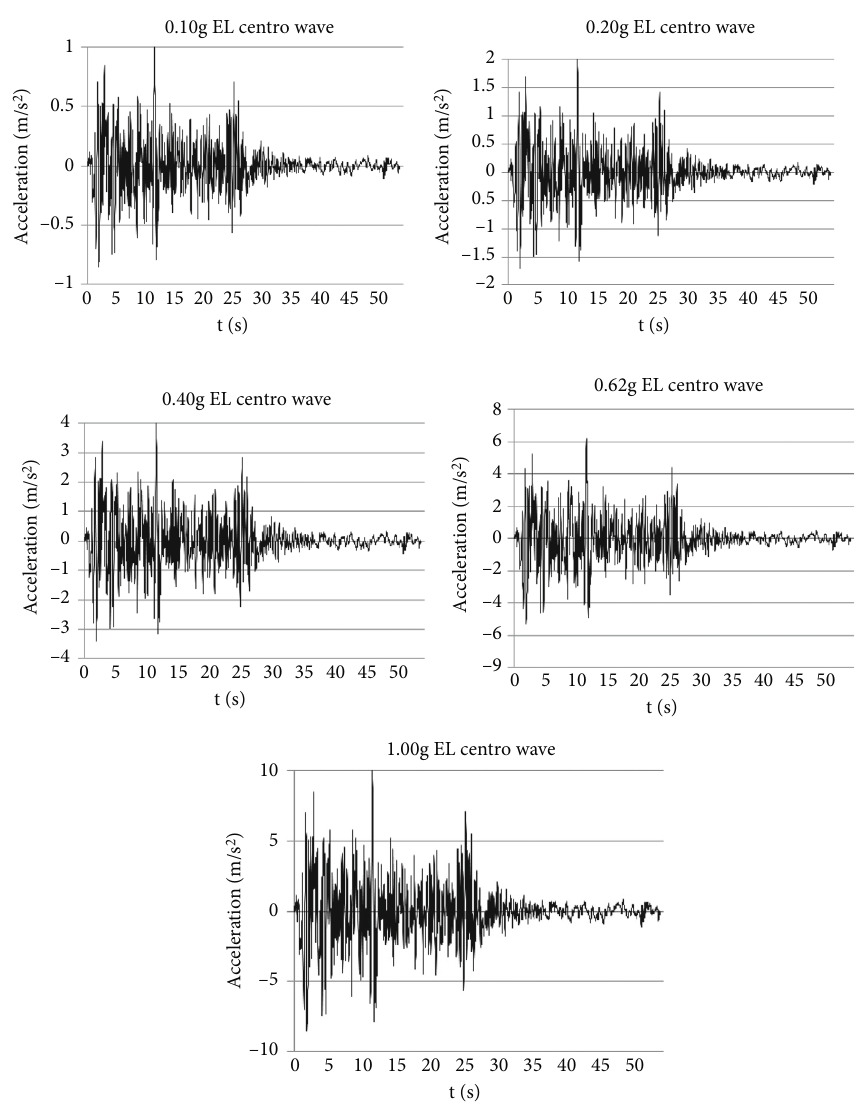
Figure 4: El Centro wave under fi ve sets of